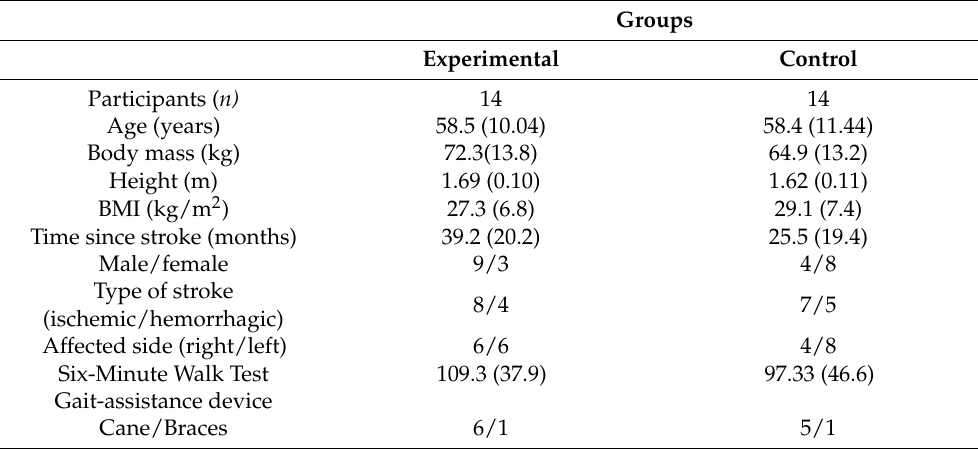
Table 1. Mean (standard deviation) of anthropometric characteristics in experimental and control groups.